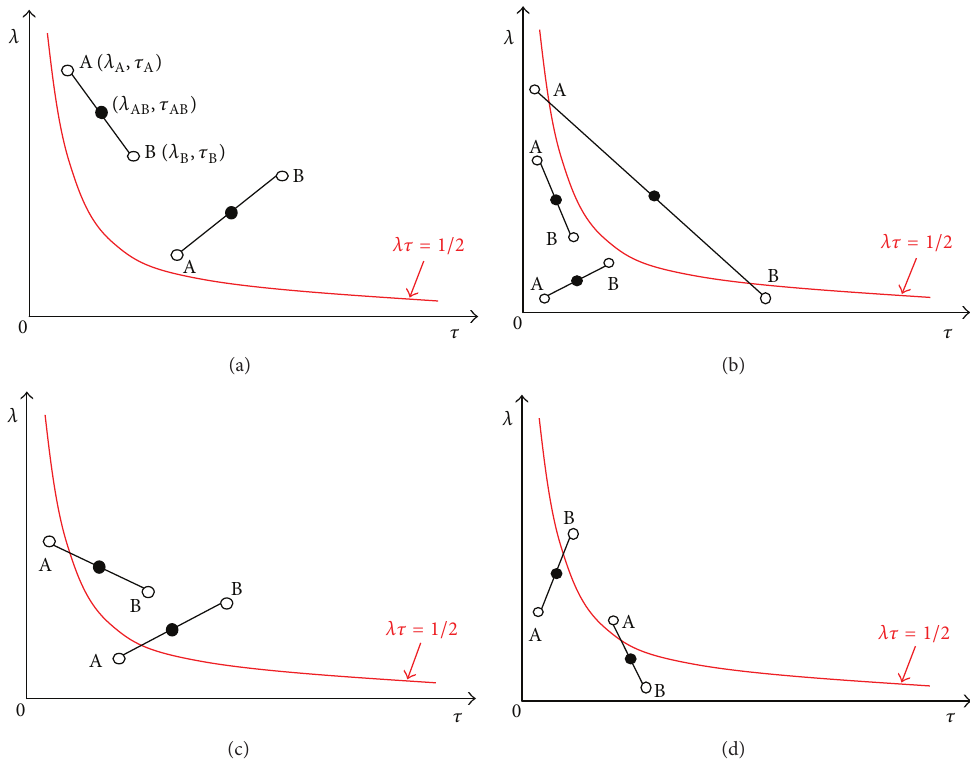
Figure 2: Model parameters in 𝜆 - 𝜏 plot. (a) Case 1, (b) Case 2, (c) Case 3 with 𝜆 AB 𝜏 AB ≥ 1/2 , and (d) Case 3 with 𝜆 AB 𝜏 AB < 1/2 (color online).